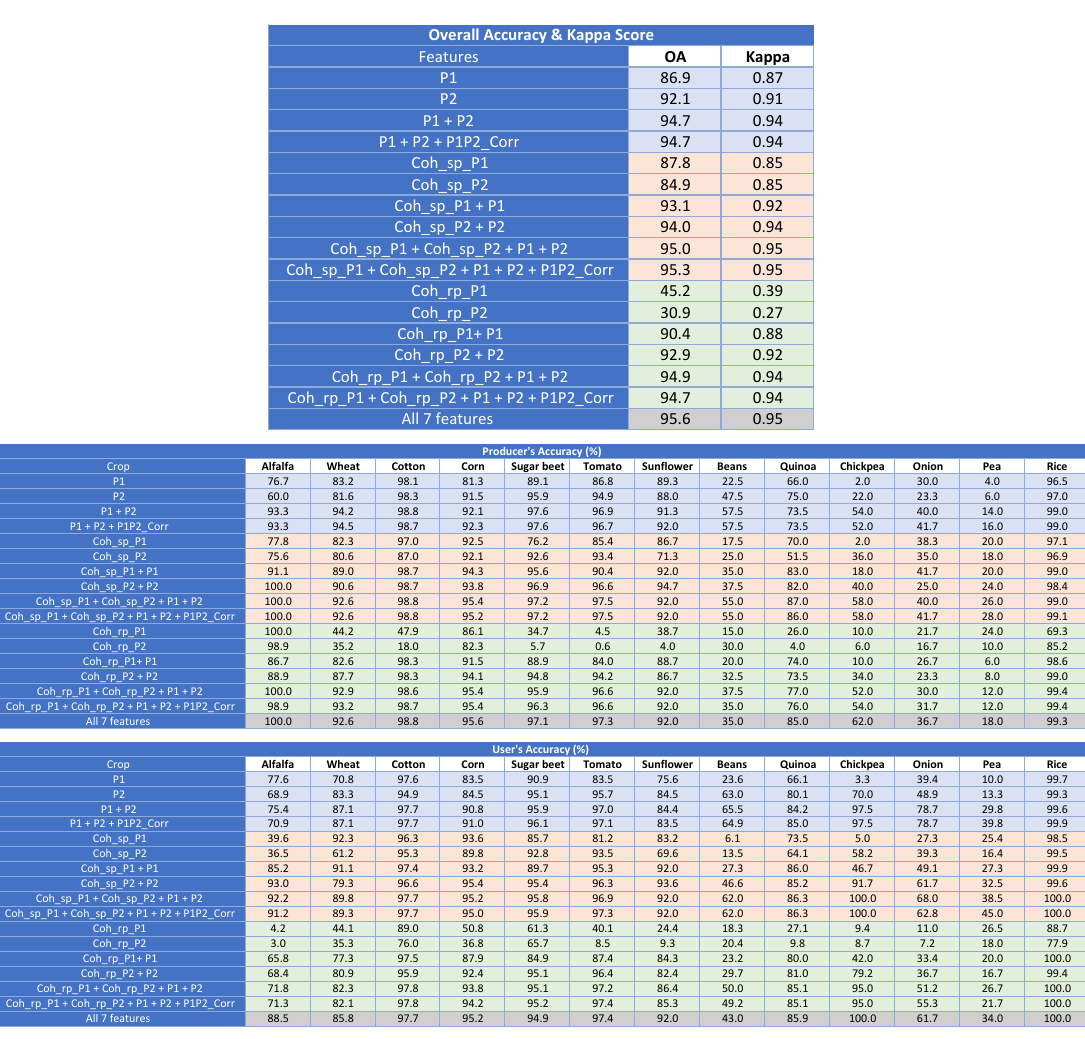
Table 7. Classification scores at field level with Pauli channels. Shading colour: blue for polarimetric features, pink for single-pass interferometric coherence features, green for repeat-pass interferometric coherence features, and grey for all